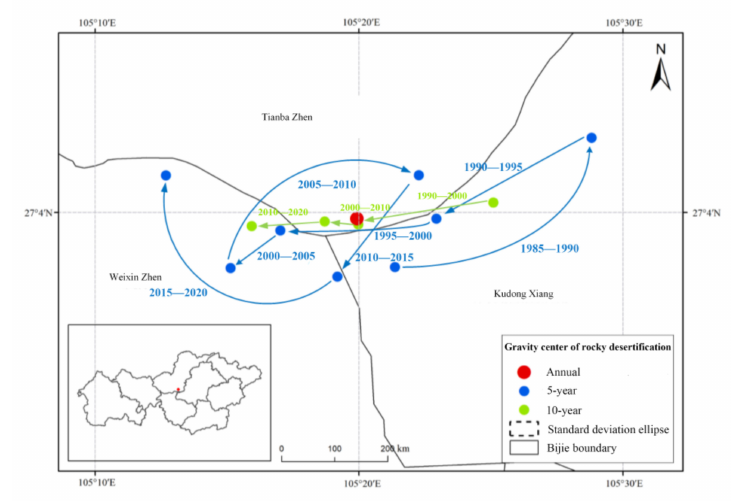
Figure 9. Gravity center migration trajectory of rocky desertification at different time